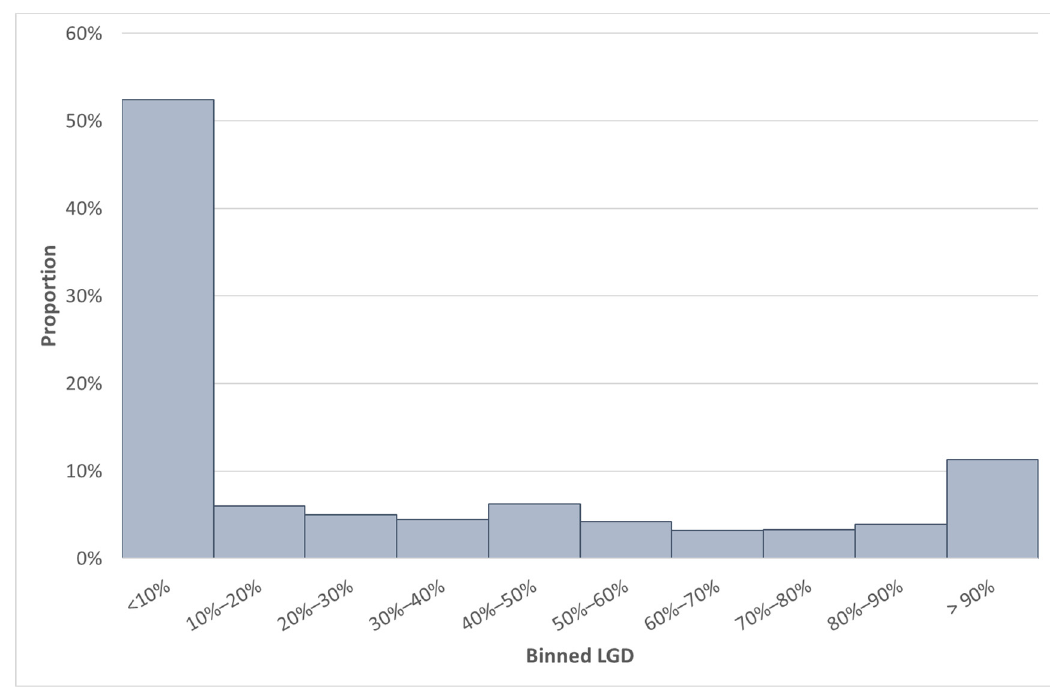
Figure 6. LGD distribution of Country AH. Table 13. Summary statistics of the LGD of 12